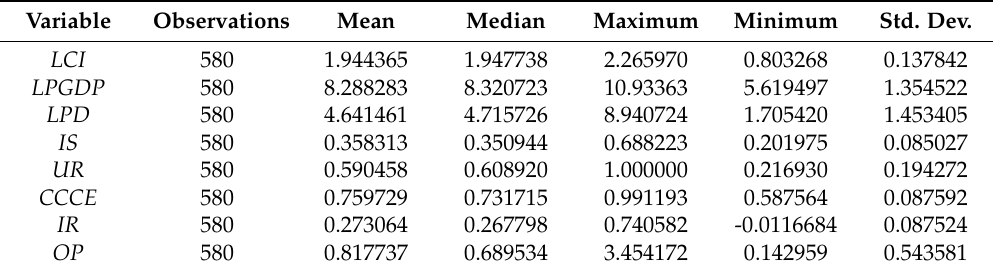
Table 5. Descriptive statistics for all variables in panel.